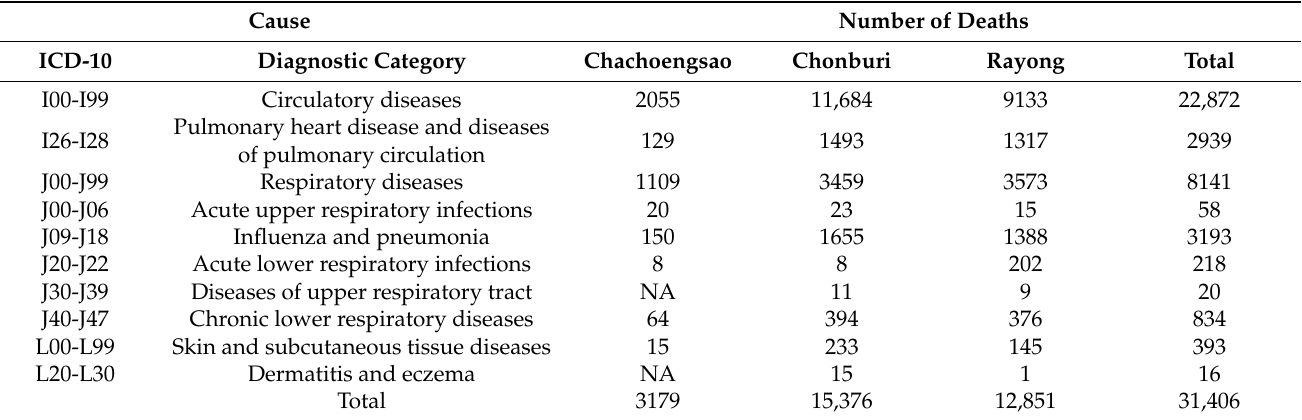
Table 3. Summary statistics for the number of deaths with various causes in the three provinces in the Eastern Economic Corridor of Thailand between 2013 and